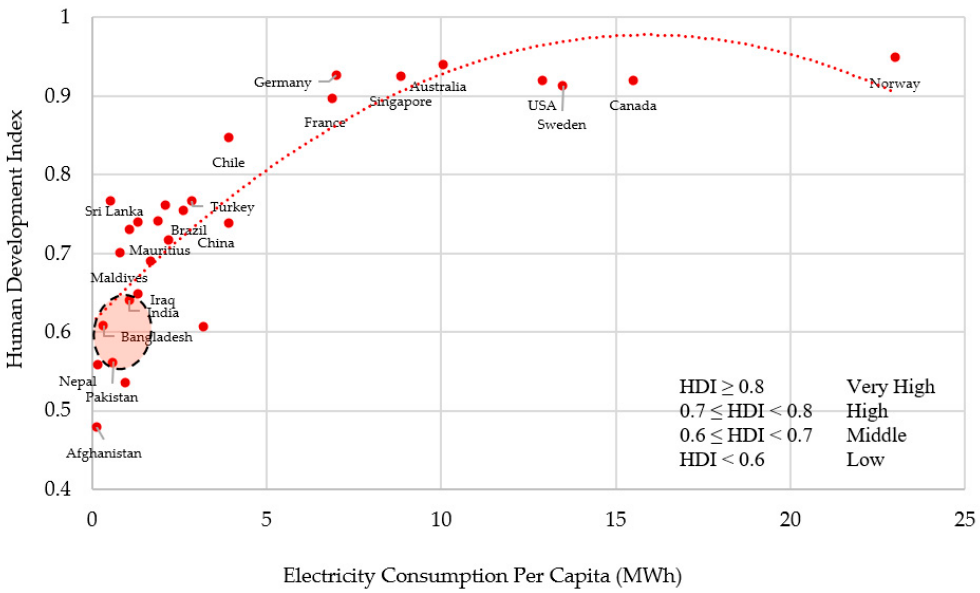
Figure 2. HDI and ECPC of 29 countries located in different climatic regions of the world show the linear and steady-state relationship between ECPC and HDI for low/middle and high development regions, respectively [10].